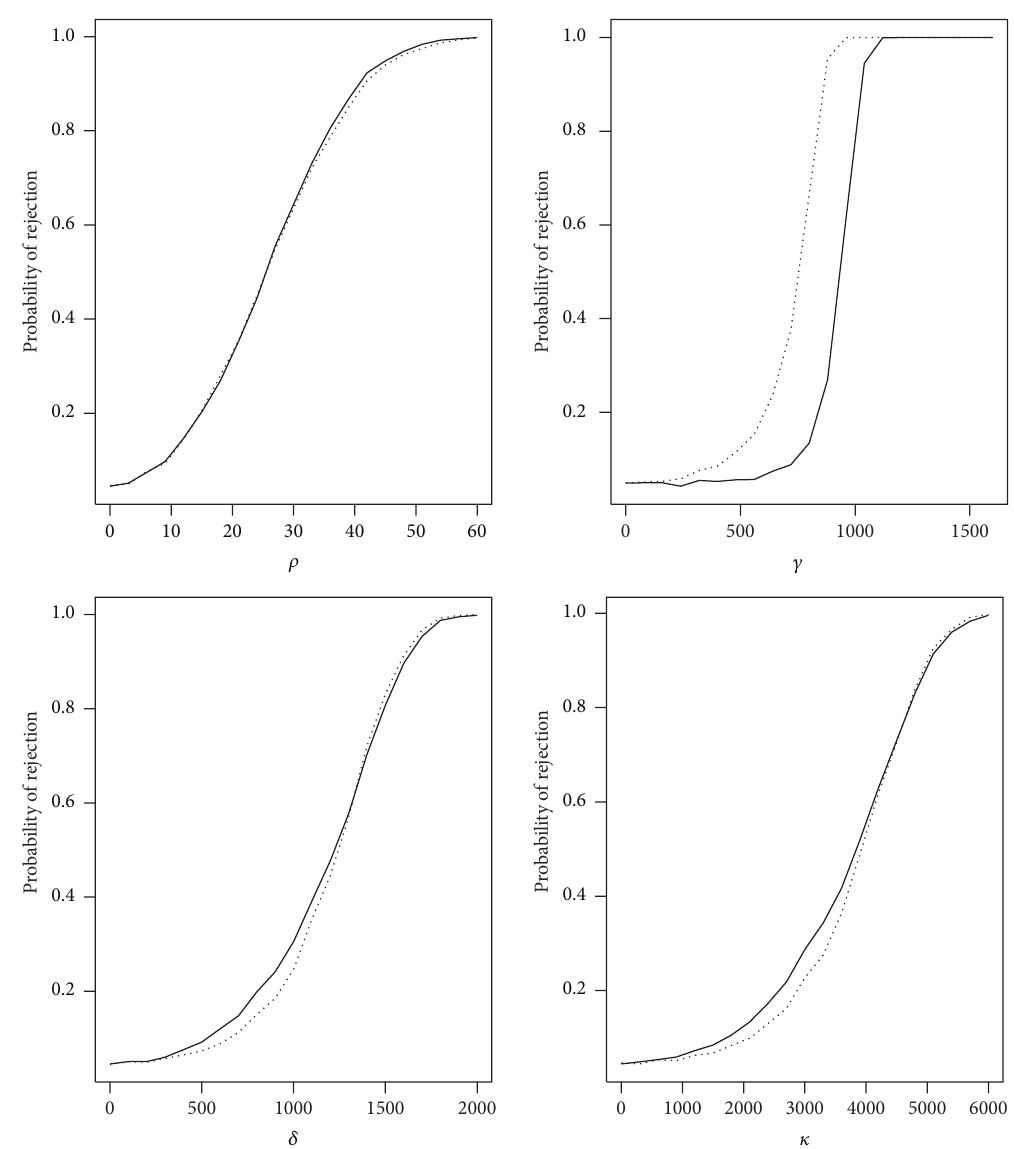
Figure 1: The empirical power functions of the KS test (smooth line) and CvM test (dotted line) for the 4-variate model using 50 × 60 -point regular lattice. The simulation is under 10000